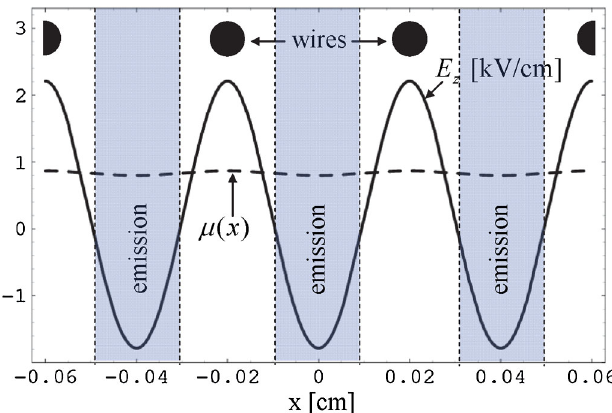
FIG. 6. Plot of shielding parameter (cid:3) ð x Þ [Eq. (C6)] and the electric field on the cathode [Eq. (2)], versus transverse position for the configuration in Fig. 4. The grid is at a distance z G ¼ 250 (cid:3) m from the cathode and the grid potential is (cid:2) G ð t Þ ¼ t Þ þ 36 cos ð 2 ! t Þ (cid:3) 33 cos ð 3 ! t Þ in units of (cid:3) 360 (cid:3) 38 cos ð ! rf rf rf = 2 (cid:1) ¼ ¼ ! volts where the fundamental frequency is f rf rf . The cathode-anode 700 MHz and the plot is for t ¼ (cid:1)=! rf gap is z A ¼ 1 cm , the cathode-anode potential is 50 kV, and the grid wire radius is r o ¼ 30 (cid:3) m . The shielding parameter, in the absence of space-charge, is (cid:3) ¼ 0 : 8 between the wires and (cid:3) ¼ 0 : 87 beneath the wires. It should be noted that the electron flux from the cathode is a sensitive function of (cid:3) ð x Þ . Electron emission from the cathode is transversely limited to the regions near the minima of (cid:3) ð x Þ